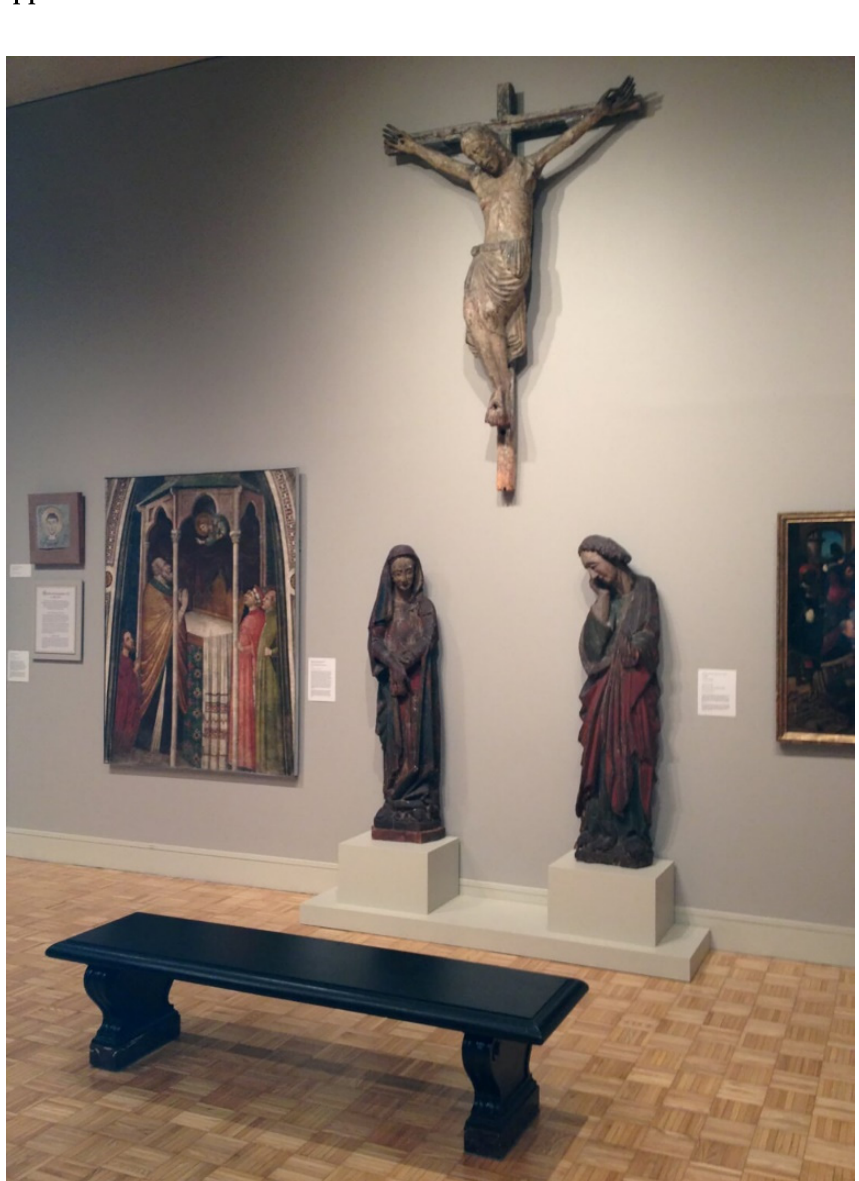
Figure A1. Reinstallation of Spanish Crucifix in 2013 at Memorial Art Gallery of the University of Rochester Medieval Art Gallery. Source: 52.34 Memorial Art Gallery of the University of Rochester. (Photograph taken by the author.).